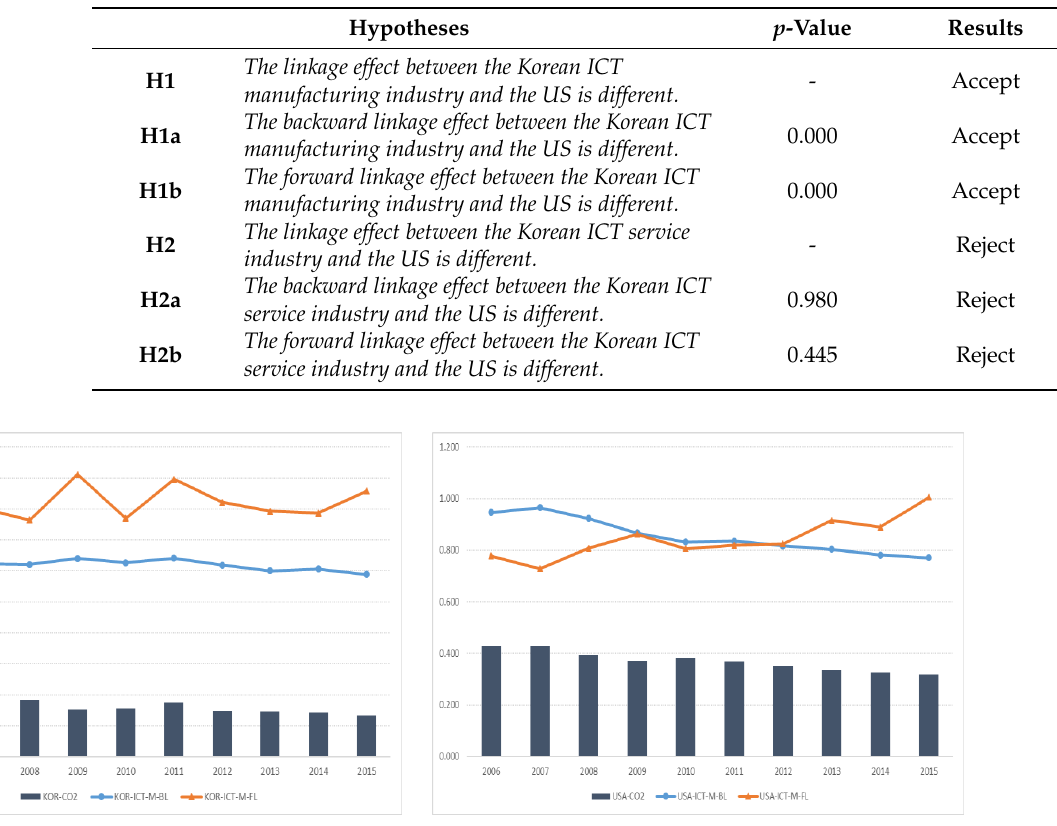
Table 10. Results of hypothesis testing.